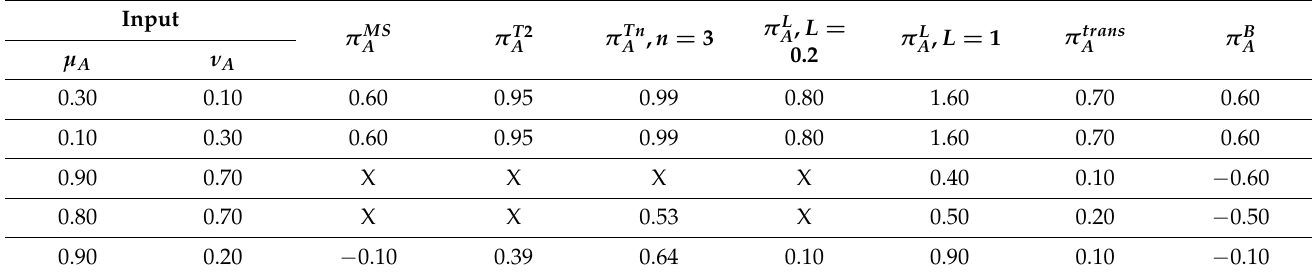
Table 1. Uncertainty degrees for various IFS